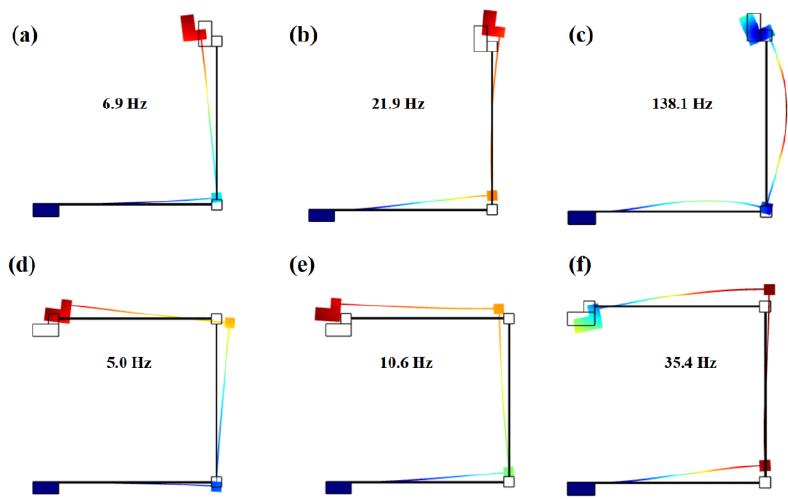
Figure 2. Modal analysis: ( a ) first modal, ( b ) second modal, and ( c ) third modal of the L-shaped PVEH; ( d ) first modal, ( e ) second modal, and ( f ) third modal of the U-shaped PVEH.